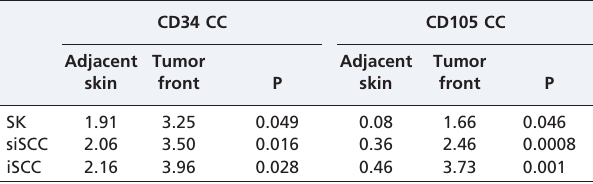
Table 1 - Mean CD34 and CD105 Chalkley counts in stroma from tumor fronts and adjacent non-neoplastic skin.